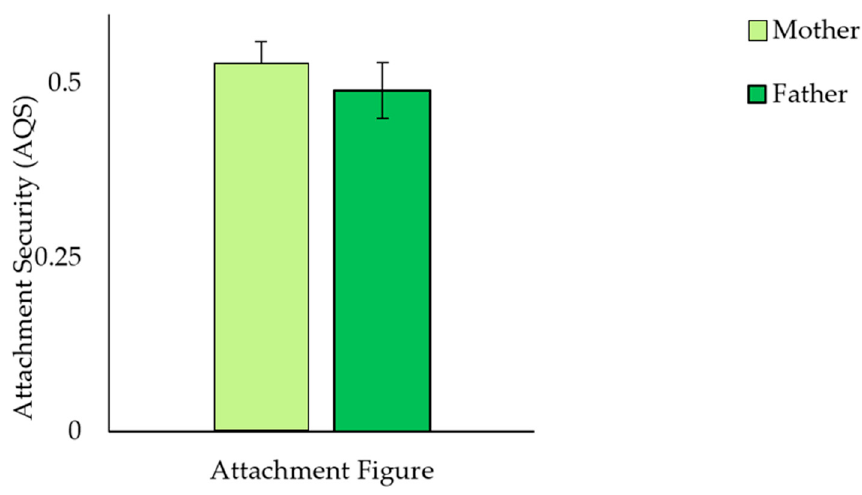
Figure 4. Attachment security (AQS) to mother and father (means and SE).